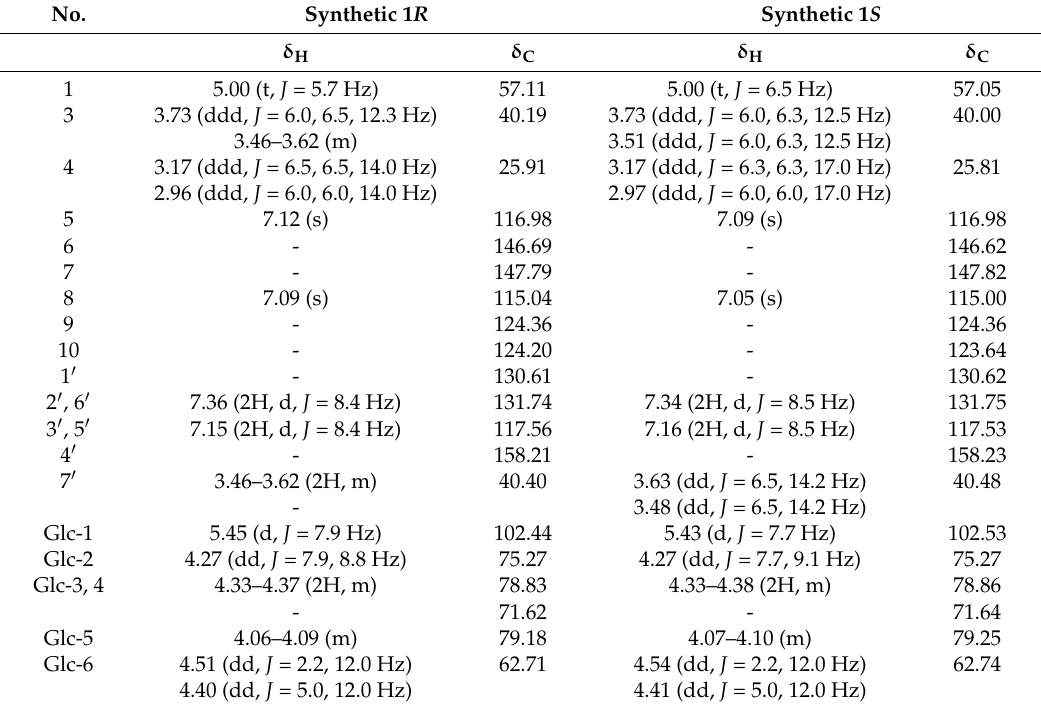
Table 3. NMR data for synthetic 1 R and 1 S in pyridine- d 5